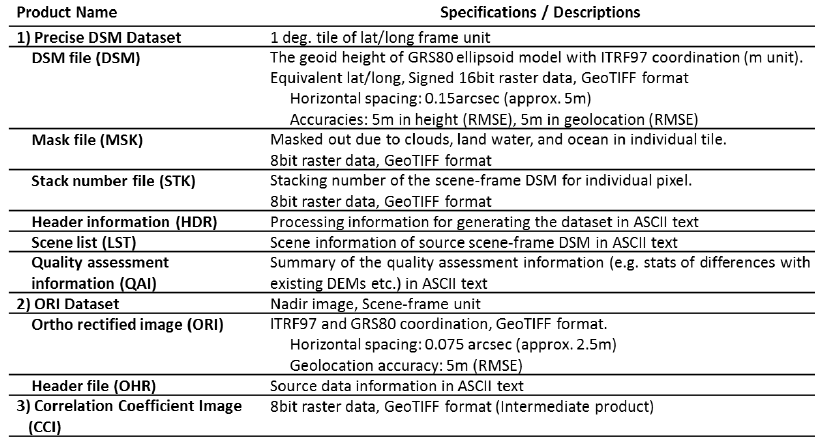
Figure 2. The status of PRISM stereo scenes in the archive with < 30% cloud cover. Table 2. Specifications of the “ALOS World 3D” dataset.